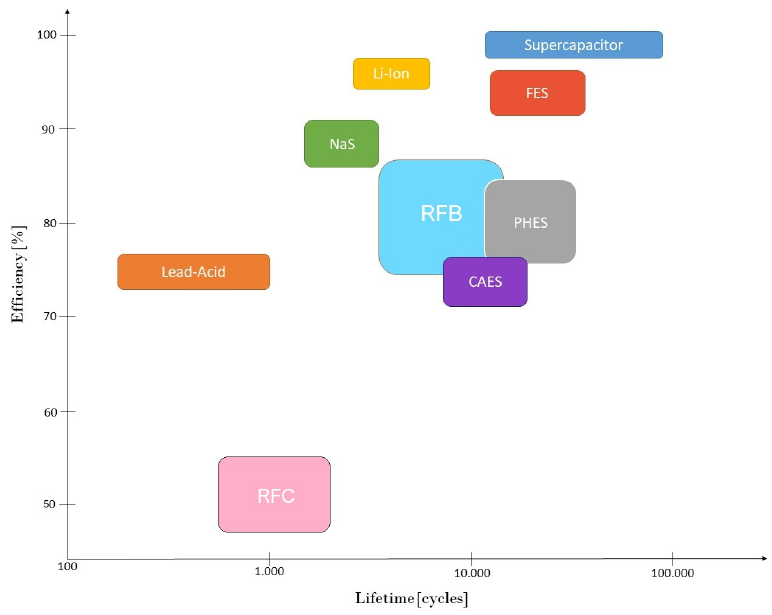
Figure 1. Efficiency and lifetime comparison of main ESS. Information obtained from